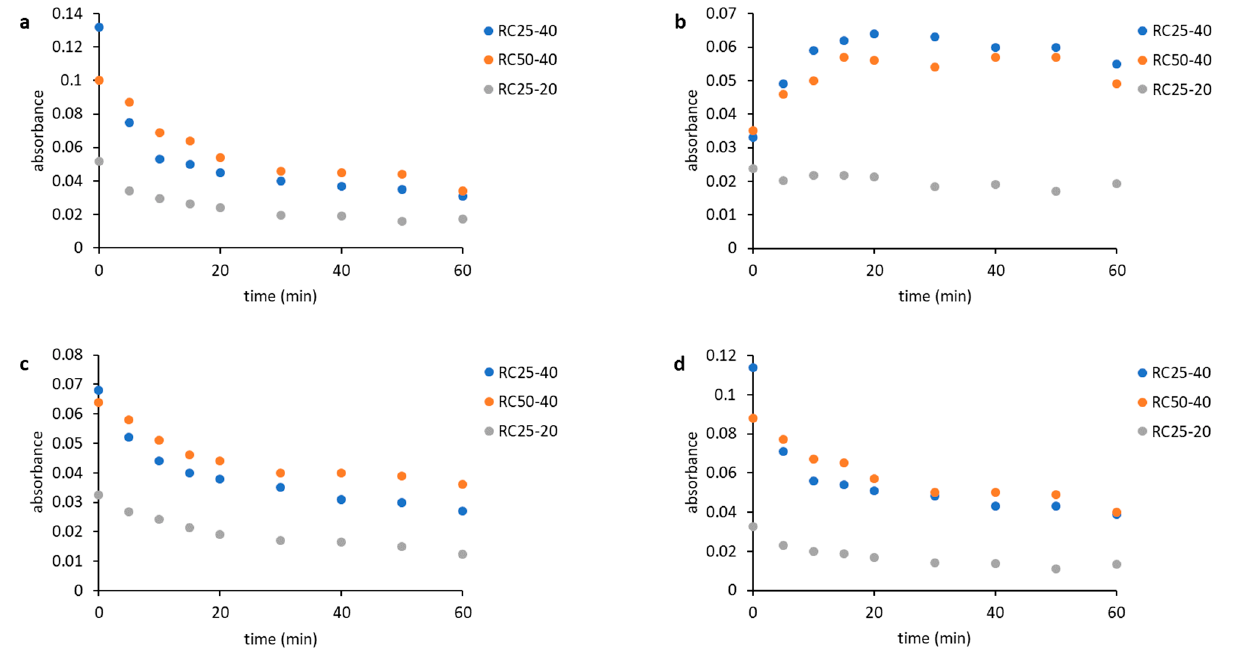
Figure 3. Time dependence of absorbances of studied RF mixtures, ( a ) 1151 cm − 1 , ( b ) 1114 cm − 1 , ( c ) 1057 cm − 1 , ( d ) 964 cm − 1 .